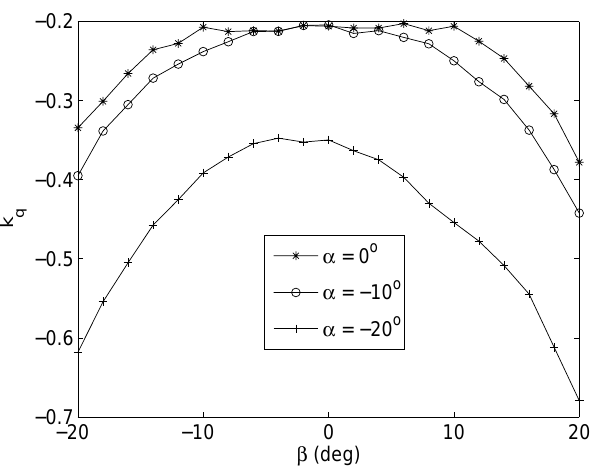
Fig. 9. Calibration coefficient k p for static pressure against calibra- tion angle β for three attack angles α .